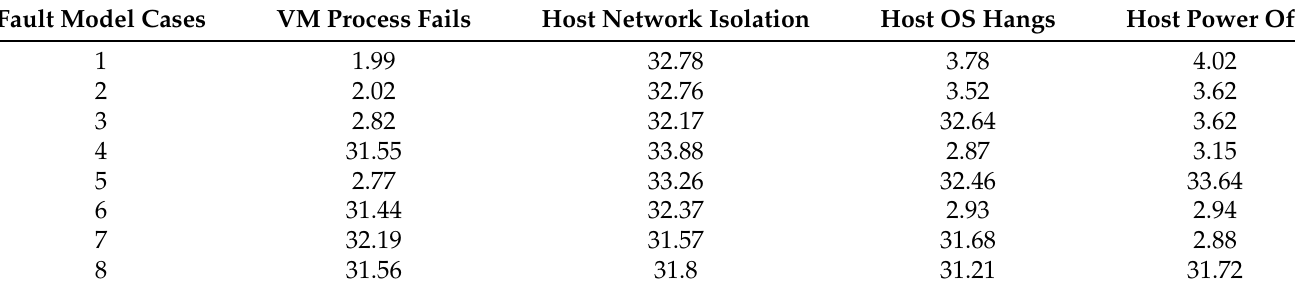
Table 11. Detection time of various system faults in each fault model case (in